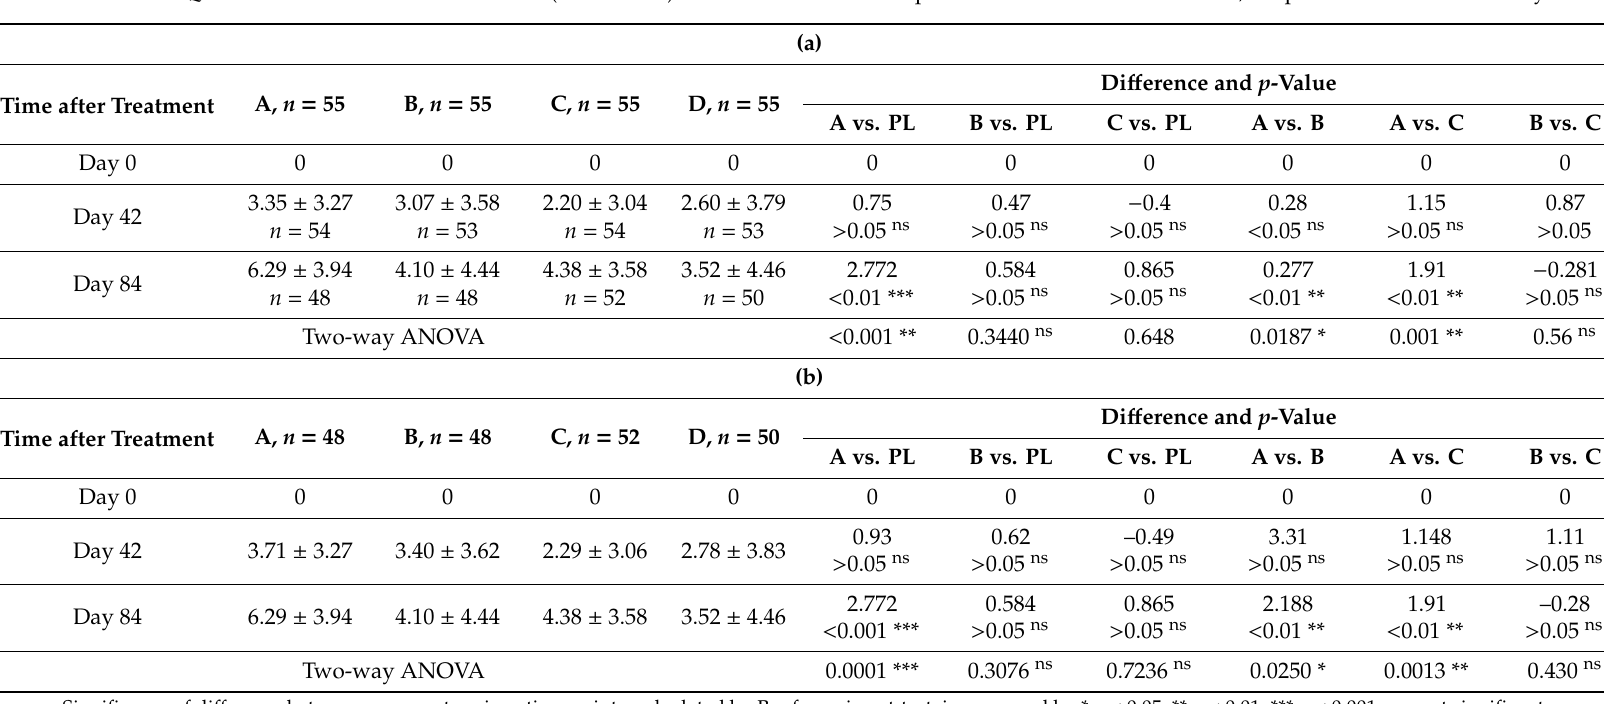
Table A6. ( a ). The change from baseline of UQOL emotional health domain score (mean ± SD) over time. All patients including dropouts—ITT analysis. ( b ). The change from baseline of UQOL emotional health domain score (mean ± SD) over time. Patients completed the treatment and all tests, dropouts excluded—PP